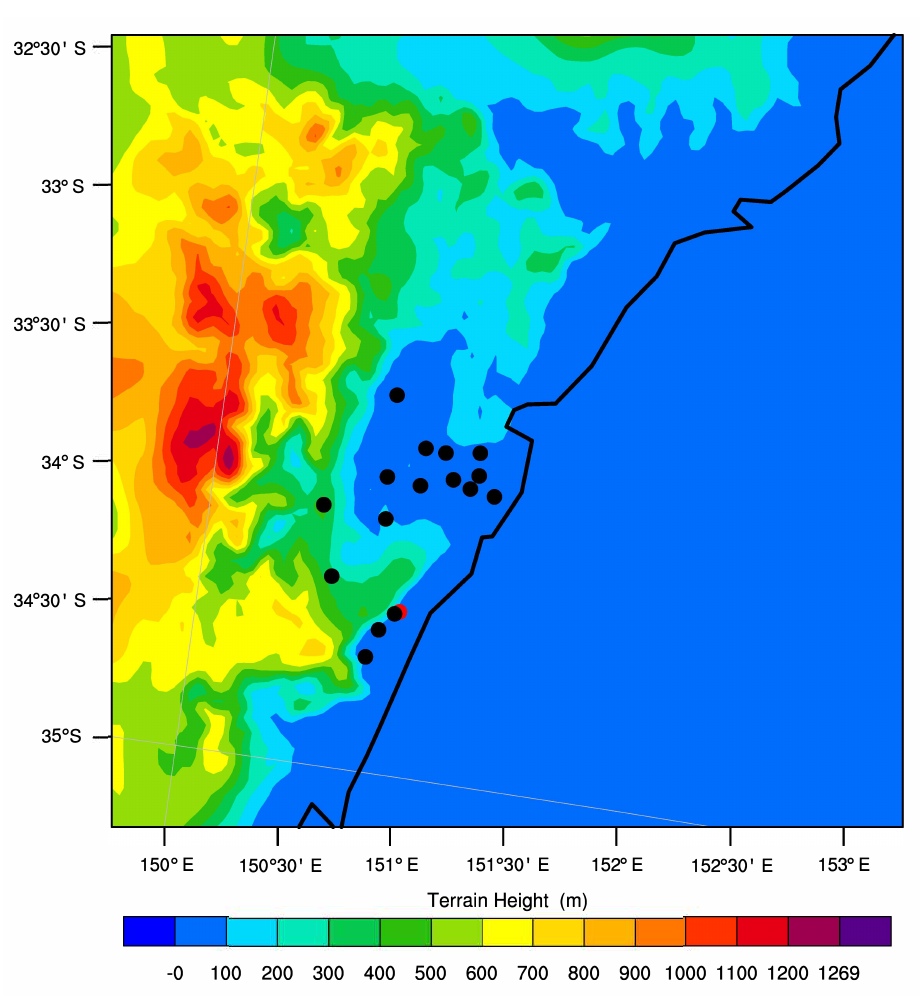
Figure 1. Terrain map of the model’s innermost domain showing locations of measurements (dots). Site of isoprene and formaldehyde measurements shown as red